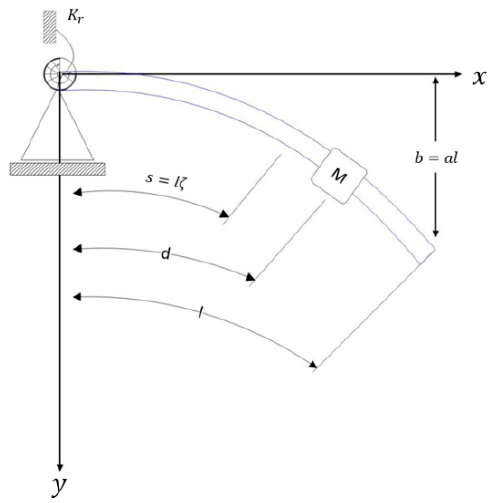
Figure 1. Configuration of a beam carrying a lumped mass.